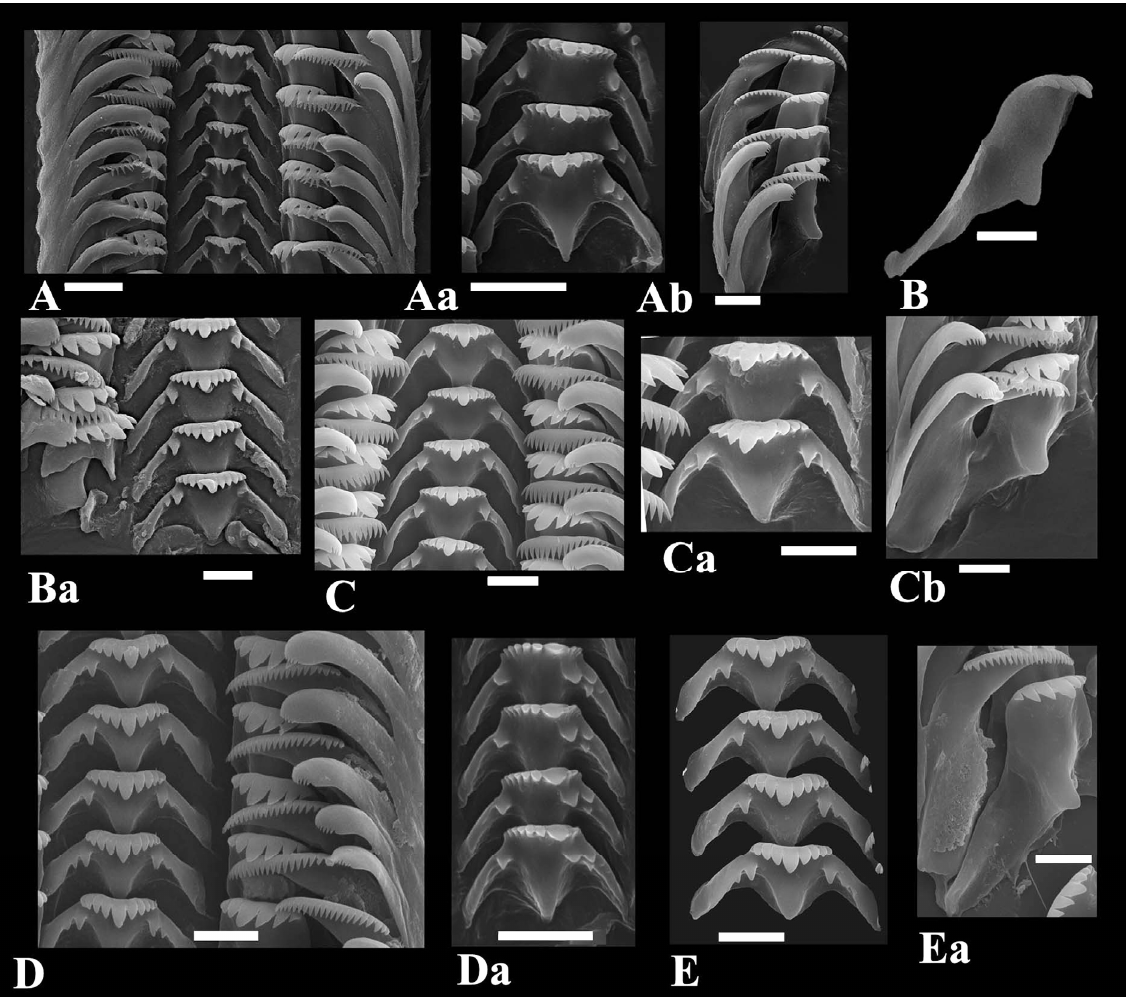
Figure 4. Radular teeth of Kolhymamnicola species. ( A , Aa , Ab ) K. wasiliewae , IBSS, leg. L. Prozorova, ( B , Ba ) K. kolhymensis , IBSS, No.2120b. ( C , Ca , Cb ) K. ochotica , IBSS, No. 4325. ( D , E ) K. miyadii , IBSS, No. 111-97. Scale bars 10 μ m.